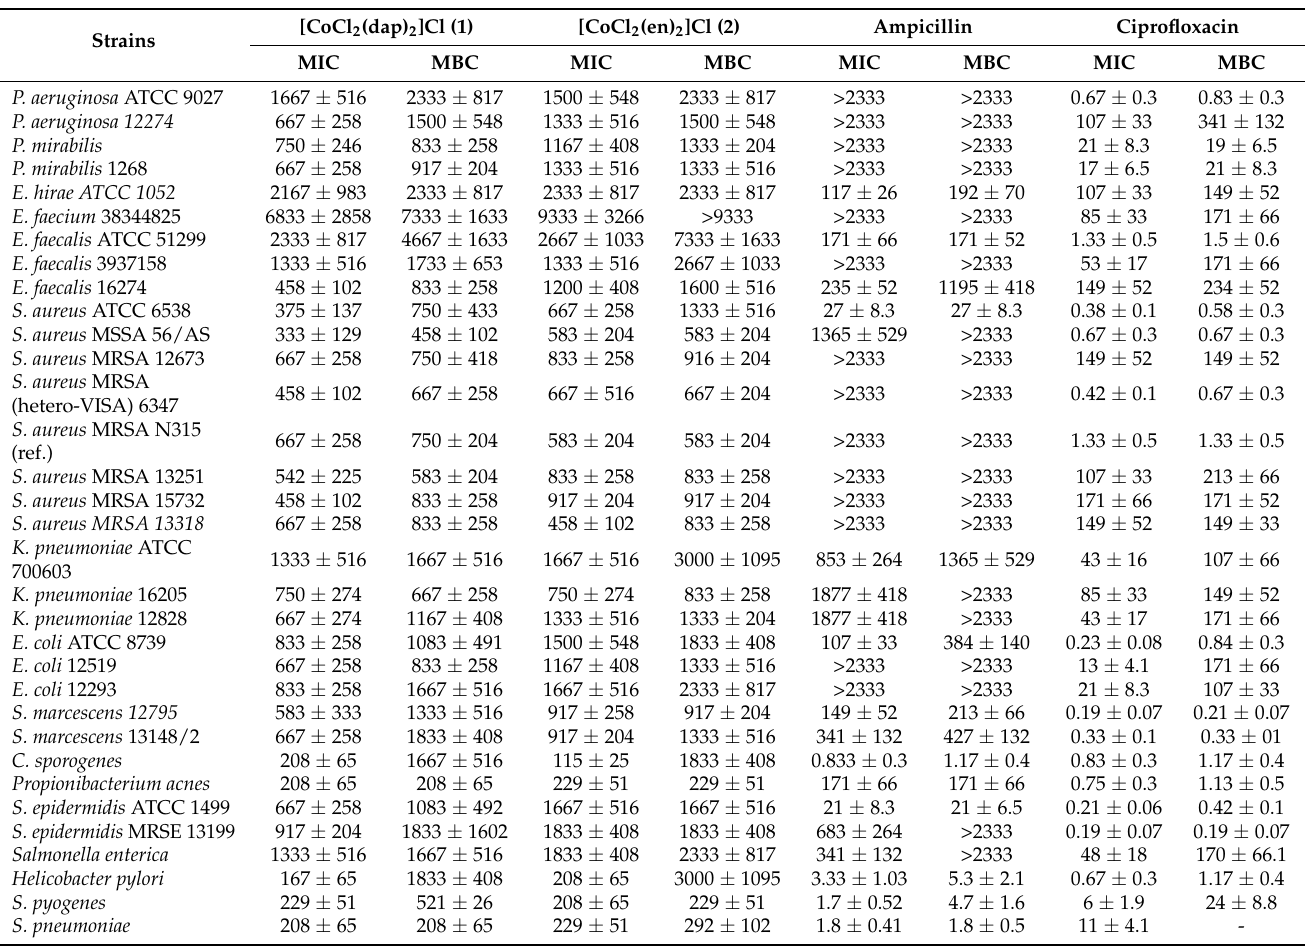
Table 1. MIC and MBC values in µ g/mL of [CoCl 2 (dap) 2 ]Cl ( 1 ), [CoCl 2 (en) 2 ]Cl ( 2 ), ampicillin, and ciprofloxacin against selected bacteria